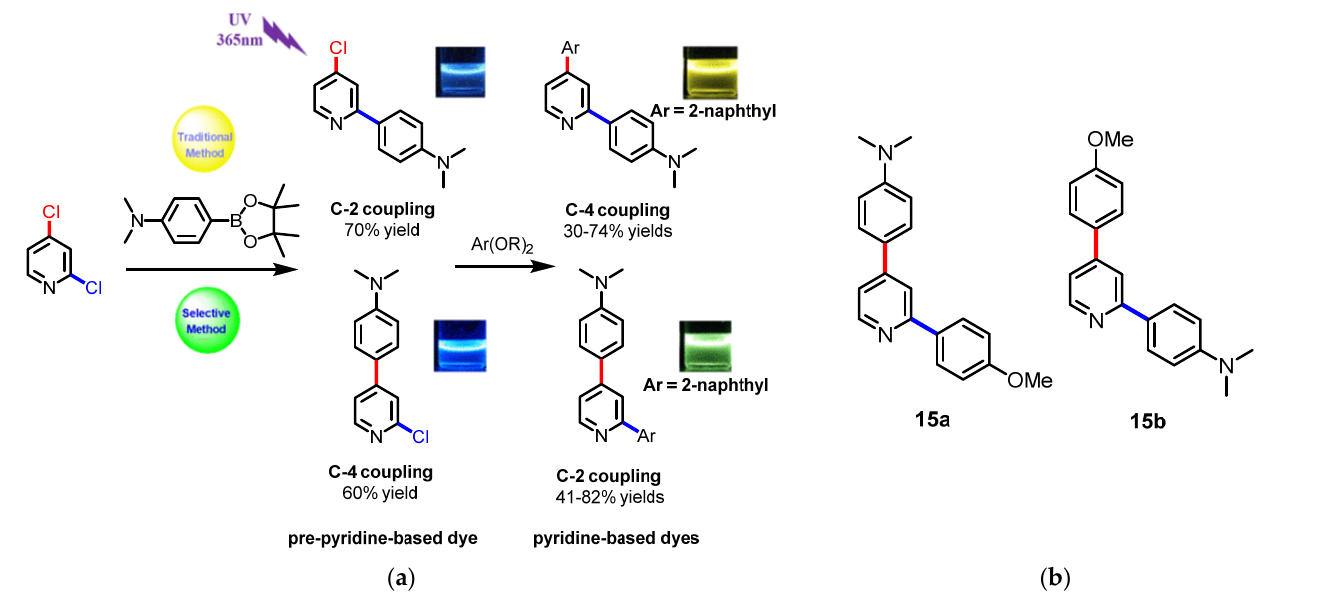
Scheme 12. ( a ) Synthesis of various pyridine derivatives. ( b ) Representative compounds 15a and 15b . Adapted from [41].